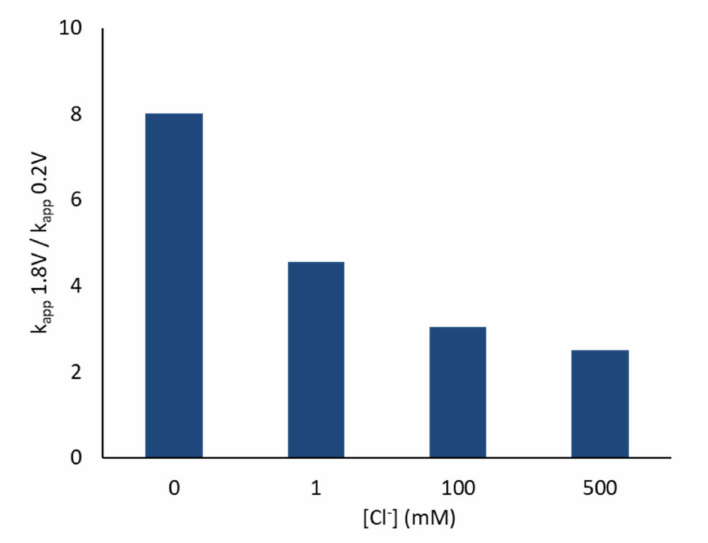
Figure 5. Ratio between the apparent kinetic constant evaluated at 1.8 and 0.2 V for different chloride